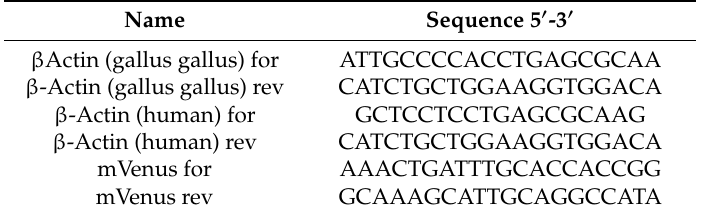
Table 2. Oligonucleotide primers used for viral DNA quantification in qPCR